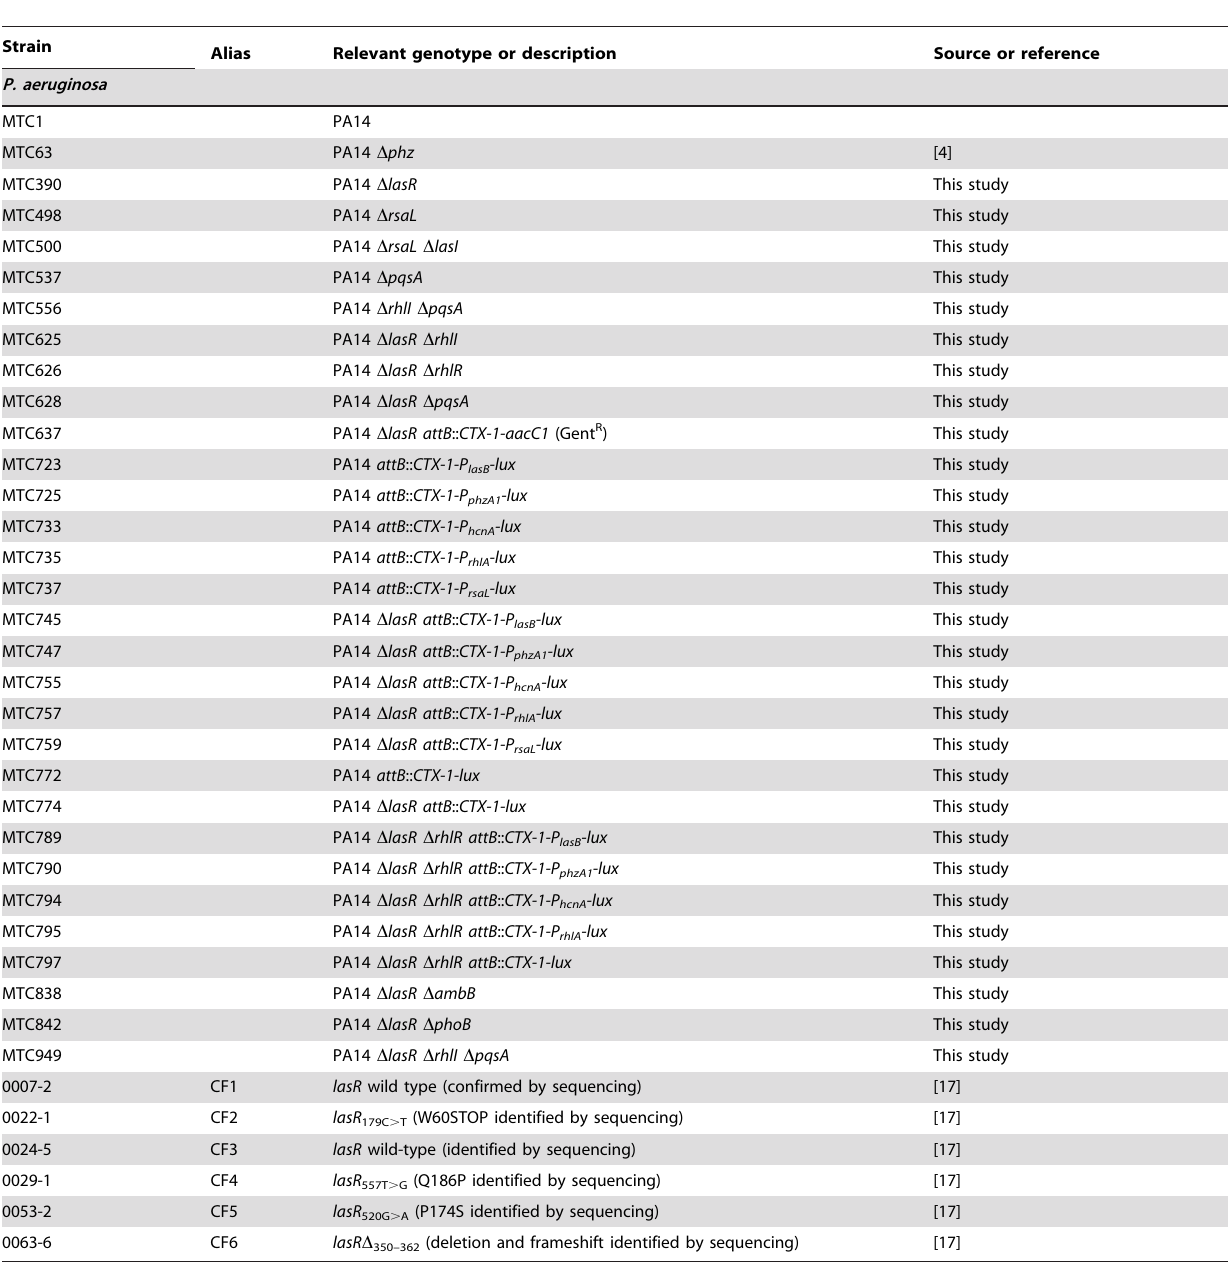
Table 1. Strains used in this study.